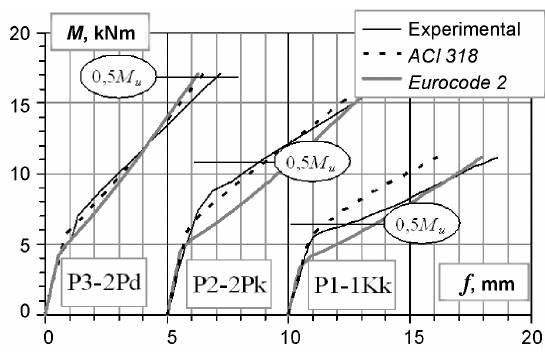
Fig. 8. Deflection of test beams (Фигаровский [Figa-